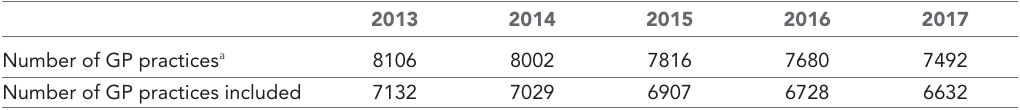
Table 1 Total number of GP practices in England and number of GP practices included in this study